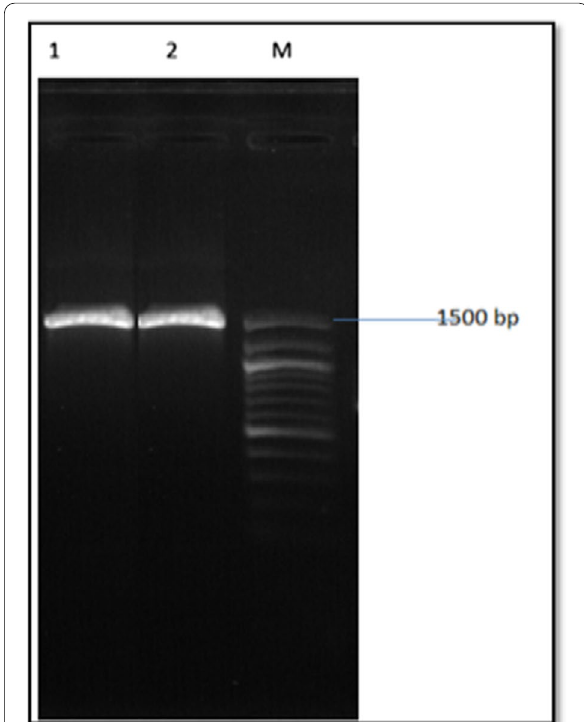
Fig. 1 Agarose gel electrophoresis for the PCR product of 16 s rDNA gene (1500 bp) in Bacillus cereus Nem 212 (1) and Bacillus cereus Nem 213 (2); M: 100 bp DNA ladder (Thermo Scientific,